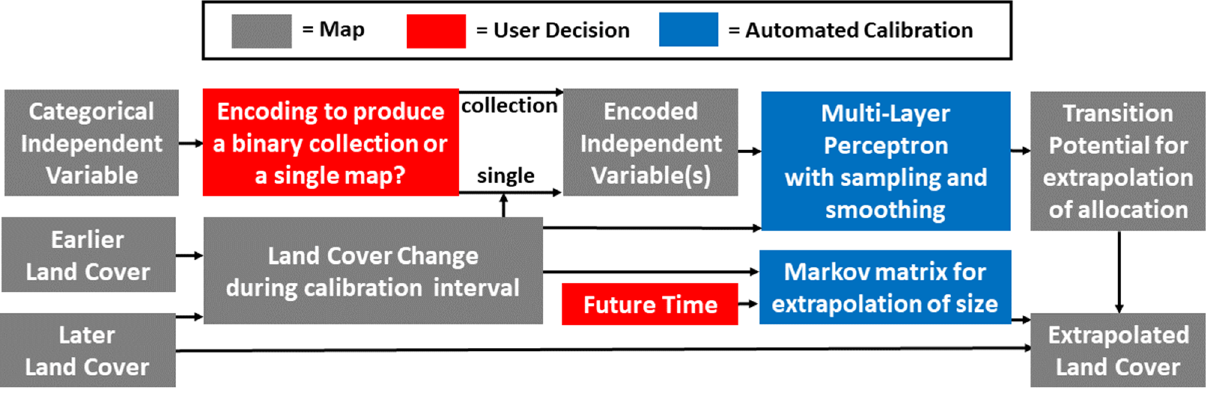
Figure 1. Flow diagram of the Land Change Modeler when using one independent variable that shows categories. Our manuscript addresses the user decision concerning the method of encoding a categorical independent variable and the decision’s implications for the transition potential map and the subsequent extrapolated land cover map.